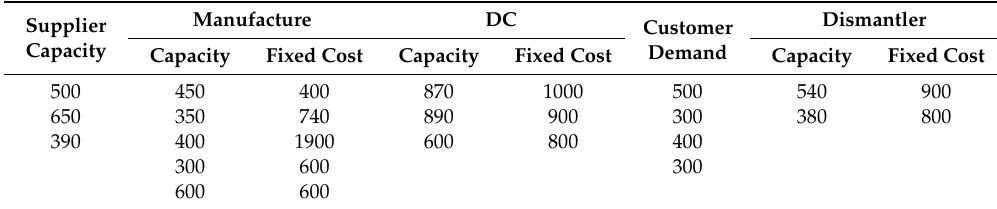
Table 11. Capacity, fixed cost (US$) and demand in Experiment 3.